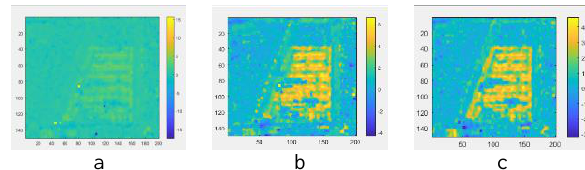
Fig. 5. Change indices in region 1 based on, (a) log-ratio Yamaguchi Odd, (b) log-ratio Yamaguchi Dbl, (c) log-ratio Yamaguchi Vol Fig . 6 shows the change maps obtained by different